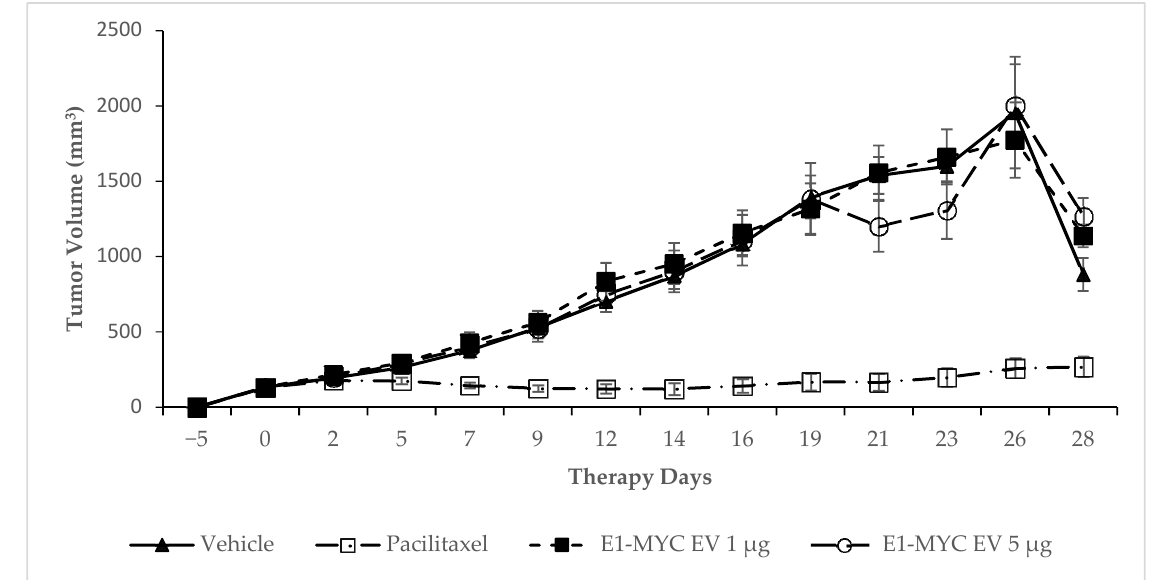
Figure 3. Effect of E1-MYC exosome on tumor growth. Mice were injected with either vehicle, Paclitaxel, or two different doses of E1-MYC exosome (1 μg or 5 μg), and tumor volume was recorded thrice weekly. Animals treated with E1-MYC exosome had no difference from vehicle control in terms of tumor growth. Results represent the mean ± SEM, n = 8 for all groups from day 0 to day 16. After day 16, tumor volume in some exosome- or vehicle-treated mice started to exceed 2000 mm 3 . Euthanizing mice with large tumor volumes reduced the average increase in tumor volume and eventually reduced the tumor volume. At day 28, the vehicle and exosome groups each had only two surviving mice.